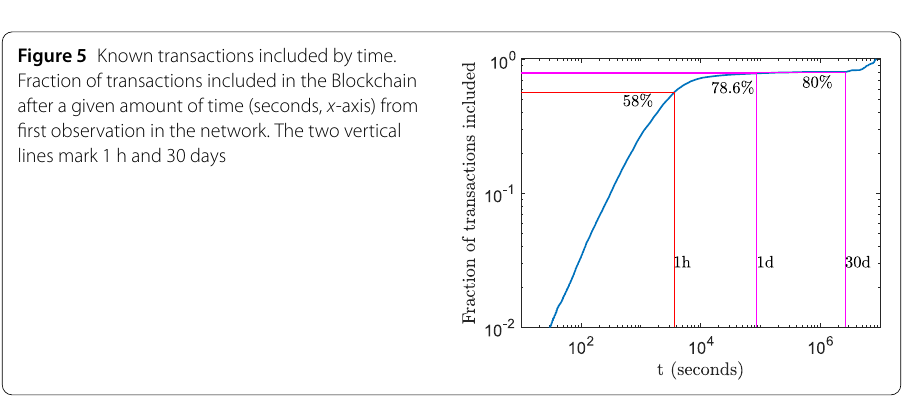
Figure 4 Transaction stand-by time. Distribution of time intervals between the first time a transaction is observed in the network and the time when it is included into a valid block. The left plot reports time in seconds and the right plot reports time in number of blocks (approx 10 min each). The red line are best fits with exponential decay law